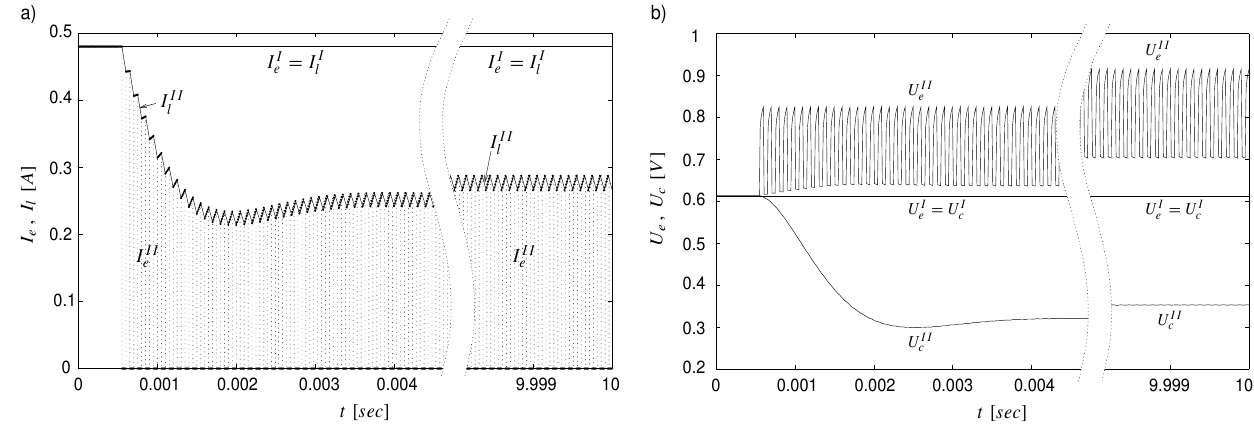
Figure 12. a) Step response of inductor current I b) the step responses of cell (=converter input) voltage U voltage U are c